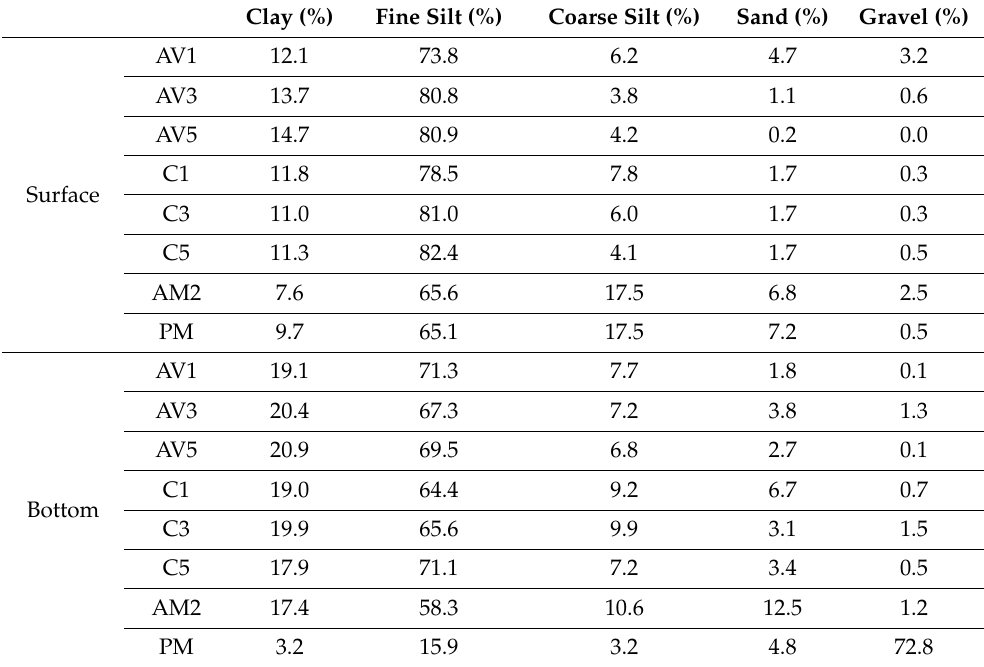
Table 1. Distribution of the different size fractions in the sediments in percentage at the surface and at the bottom of the different cores for the July 2020 campaign. Clay (%) Fine Silt (%) Coarse Silt (%) Sand (%) Gravel